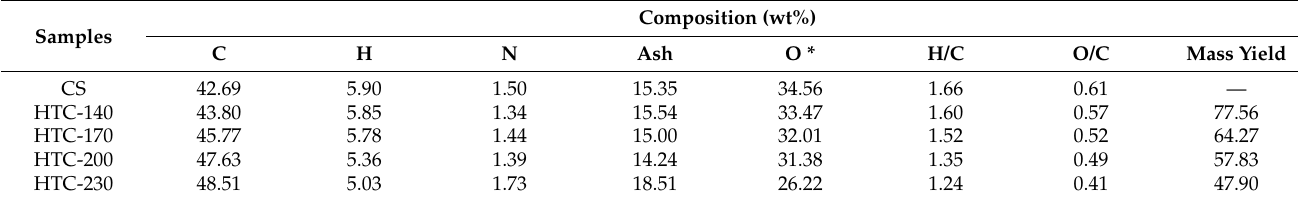
Table 1. Elemental analysis of CS and hydrochar.